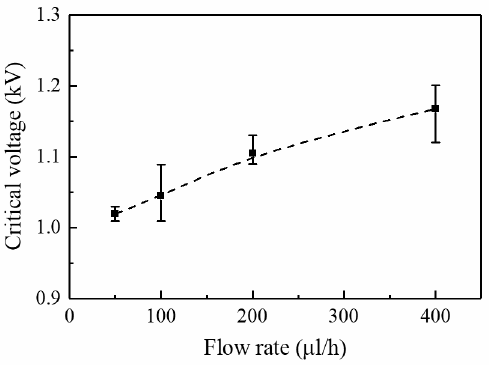
Figure 6. The effect of flow rate on critical voltage. The nozzle-to-substrate distance is 3 mm.